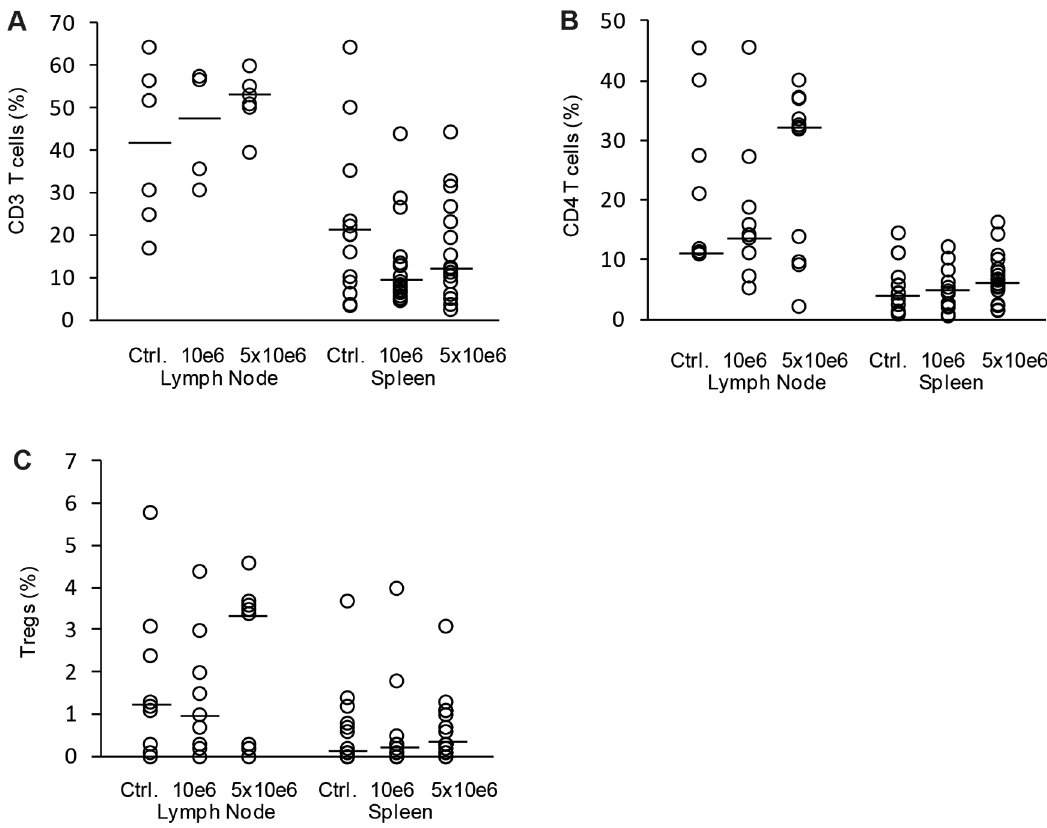
Figure 6. Assessment of T-cell populations after modified ECP therapy. T-cell subpopulations in GvHD mice treated by modified ECP were analyzed. ECP cells were isolated from wild type C57BL/6 spleens and treated with 8-Methoxypsoralen and UV-A light. Subsequently splenocytes were injected in GvHD mice after allogeneic B6 R BALB/c bone marrow transplantation. ECP was performed 4 times at weekly intervals with cell concentrations of either 1 6 10 6 cells or 5 6 10 6 cells. Control animals were treated with PBS in parallel (Ctrl.). Percentage of CD3 positive T-cells (A), of CD4 positive T-helper cells (B) and CD4 CD25 FoxP3 positive Tregs (C) from all lymph node cells or splenocytes. Analysis is based on 9 animals treated with 1 6 10 6 cells (10e6), 11 animals treated with 5 6 10 6 cells (5 6 10e6) and 9 control mice (Ctrl.). Animals were sacrificed when reaching clinical GVHD score $ 6 or at day 56 after BMT (dot-plot with median).